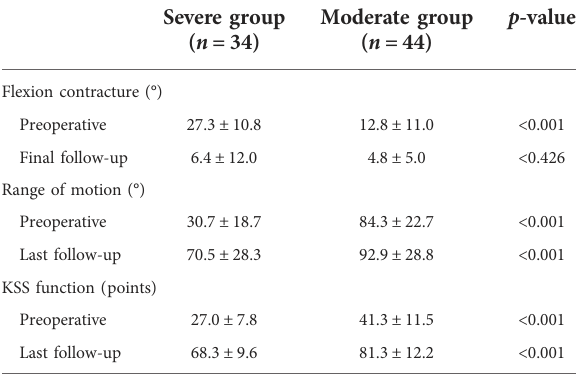
TABLE 4 Clinical outcomes between the severe and moderate groups.